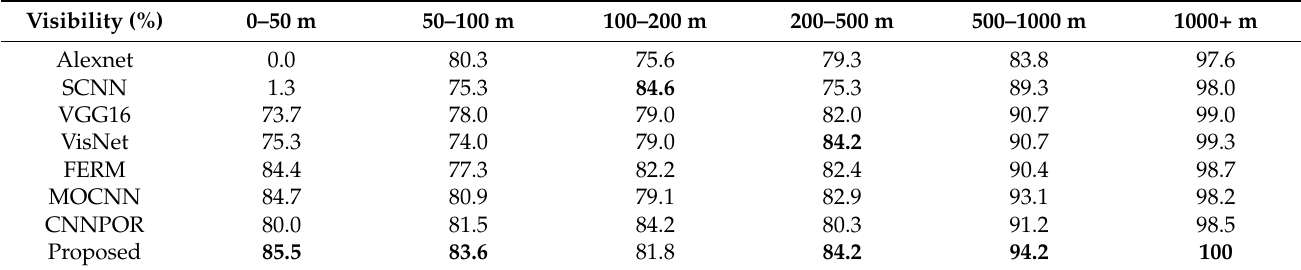
Table 7. Experimental results of different deep methods at each level with the FHVI dataset.